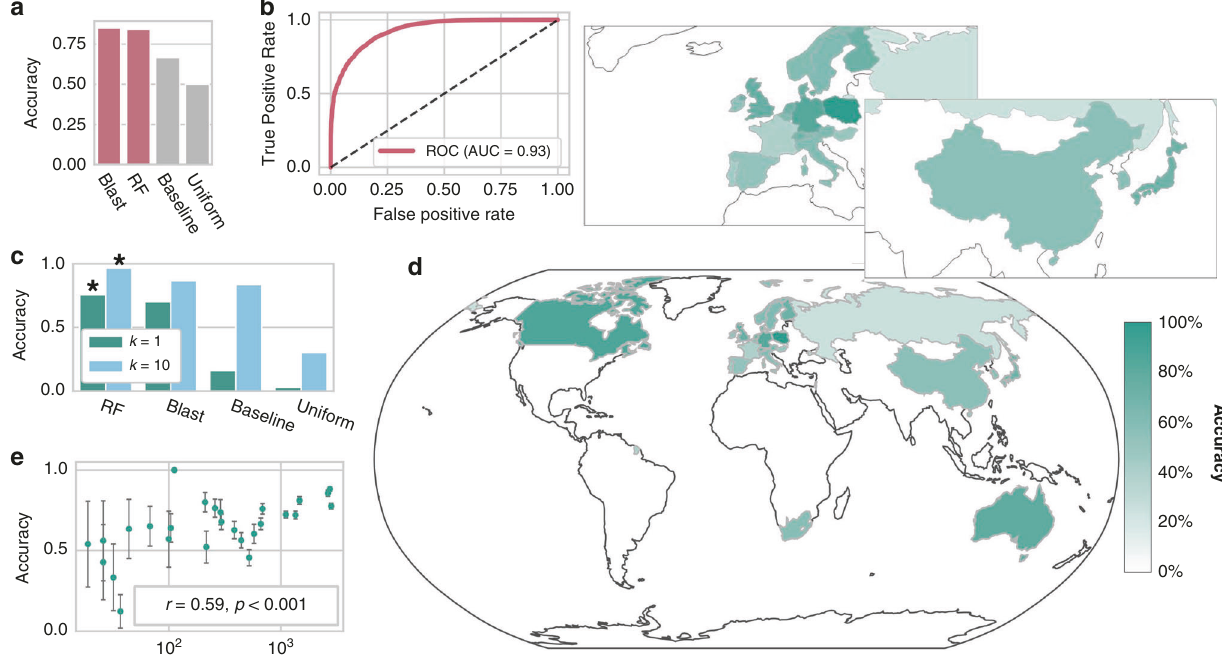
Fig. 3 Simple machine-learning methods can accurately attribute nation-of-origin of engineered DNA. a Domestic vs. International binary classi fi cation accuracy, with the United States de fi ned as domestic of BLAST, Random Forests (RF), a baseline of predicting the most abundant class from the training set and guessing uniformly randomly. Random Forests reach 84% accuracy. b Receiver-operating characteristic (ROC) curve for the RF model, with the area under the curve (AUC) shown. c Top-k test-set accuracy of multiclass classi fi cation of nation-of-origin (excluding the United States, which is classi fi ed in ( a , b )) for RF, BLAST, and a baseline of predicting the most abundant class from the training set, and guessing uniformly randomly. With only 33 countries to choose between, guessing based on top ten abundance reaches 83.8%. * indicates P < 10 − 10 , by Welch ’ s two-sided t test on 30 × 50% bootstrap replicates compared to BLAST. d Test-set accuracy of RF on the multiclass classi fi cation of nation-of-origin, as in ( c ). Colored by prediction accuracy within each nation class. Enlarged Europe and East Asia shown above. e Nation-sp e ci fi c test-set prediction accuracy correlates with the log10 of the number of training examples. Shown in green is the mean of 30× bootstrap replicates subsampling 50% of the test-set examples for each class and computing the prediction accuracy within that subset. Error bars represent standard deviations of the